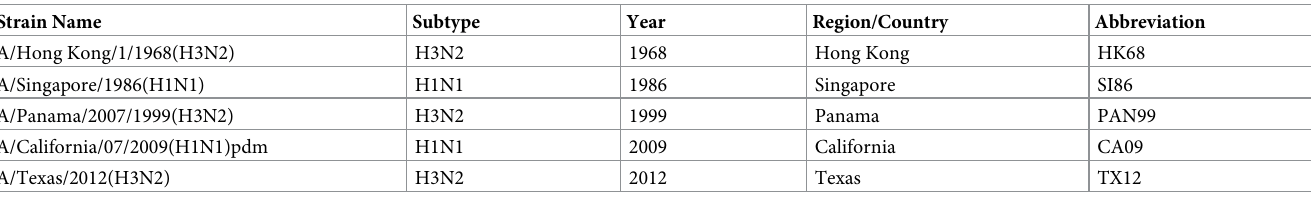
Table 1. Influenza A strains used in experiments and their